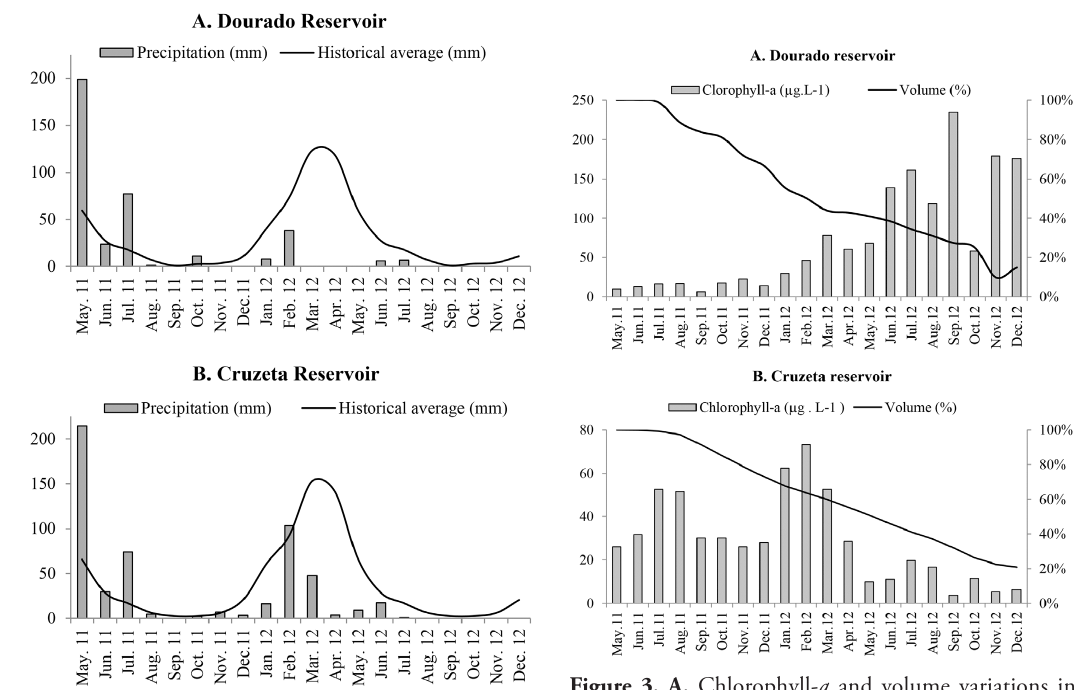
Figure 3. A. Chlorophyll- a and volume variations in Dourado reservoir B. Chlorophyll- a and volume varia- tions in Cruzeta reservoir. Volume variation percentage was calculated monthly considering the initial volume as